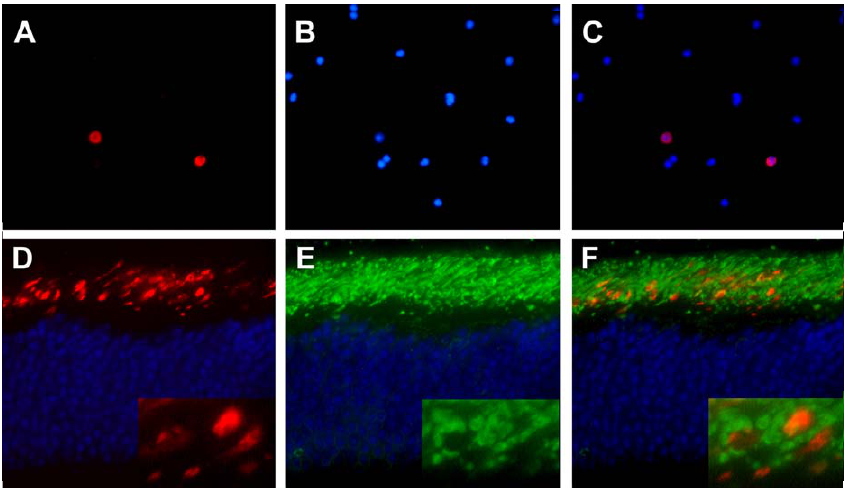
Figure 3. S-Opsin Dissociated Cell In Situ Hybridization and S-Opsin/Rhodopsin Antibody Staining on rd7 Mutant Retina (A–C) A dissociated cell in situ hybridization with an S-opsin probe (red) on dissociated rd7 mutant retinal cells stained with DAPI (blue). (C) shows the merged images. (D–F) The outer nuclear layer of an rd7 mutant retina stained by antibody for S-opsin (red) and rhodopsin (green). The scleral edge of the outer nuclear layer is up. DAPI staining is in blue. (F) shows the merged images. Insets are higher-power images of the outer segments showing non-overlap of S-opsin and rhodopsin staining in the mutant. DOI: